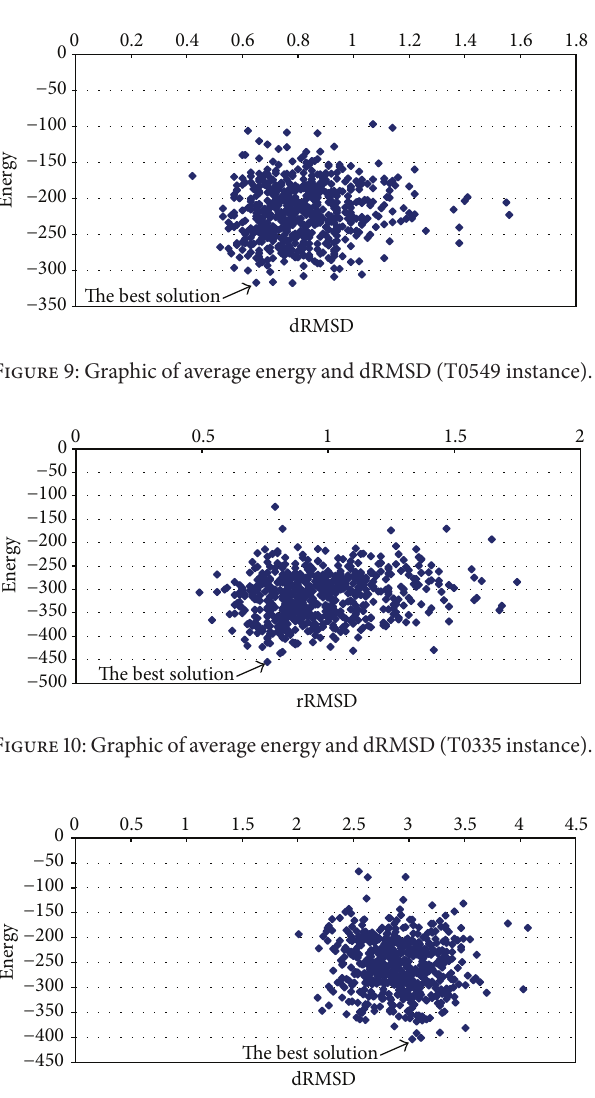
Figure 11: Graphic of average energy and dRMSD (T0281